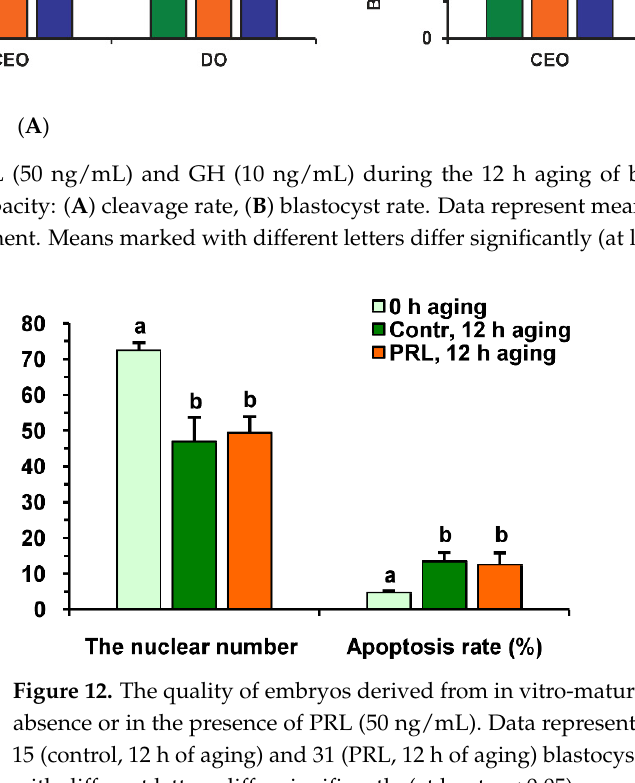
Figure 12. The quality of embryos derived from in vitro-matured bovine CEOs aged for 12 h in the absence or in the presence of PRL (50 ng/mL). Data represent means ± SEM for 46 (0 h of aging), 15 (control, 12 h of aging) and 31 (PRL, 12 h of aging) blastocysts on day 7 after IVF. Means marked with different letters differ significantly (at least p < 0.05).